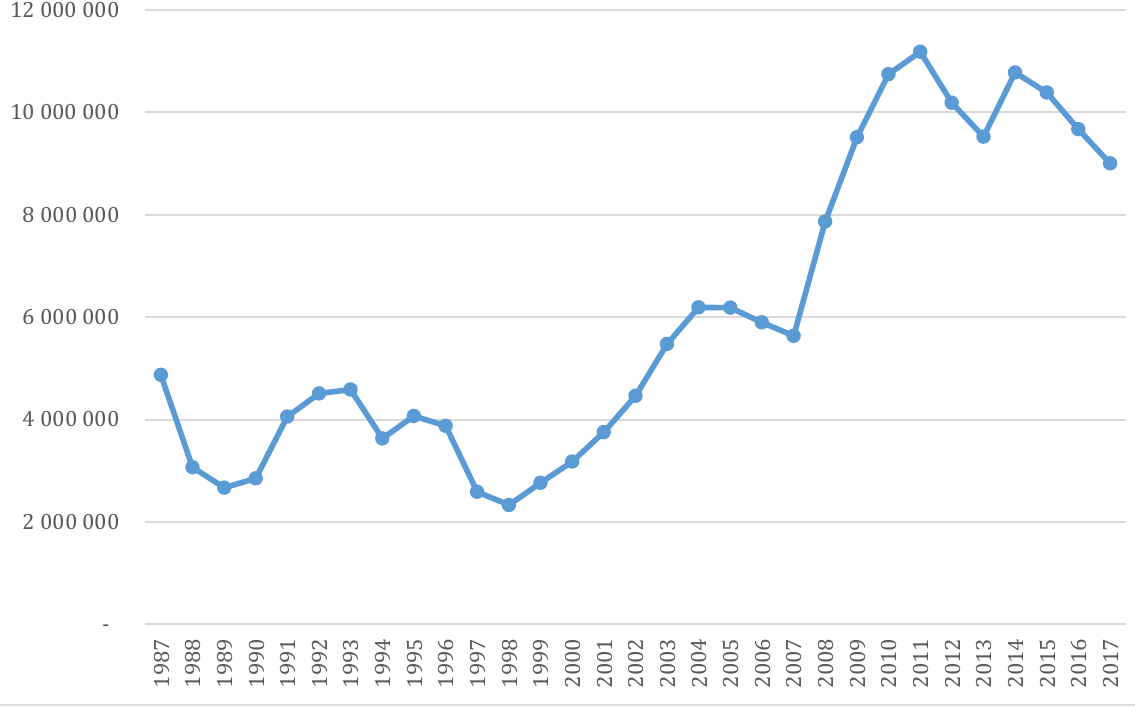
Source : FAAN, 2019